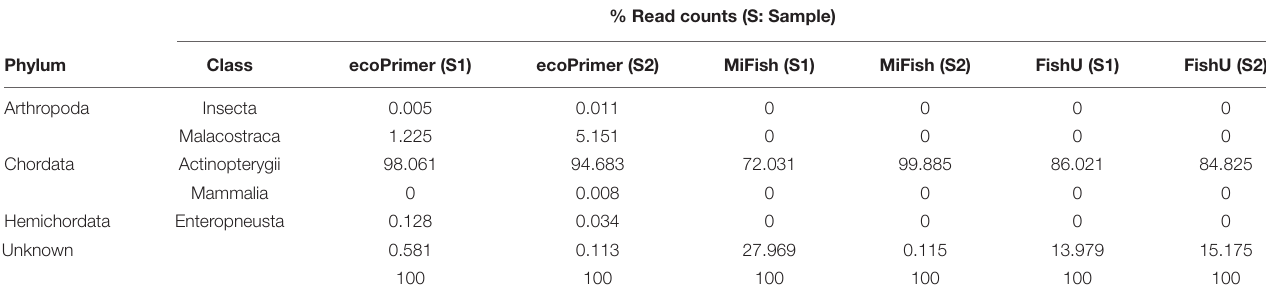
TABLE 3 | Relative abundances of the different phyla detected from three primers.